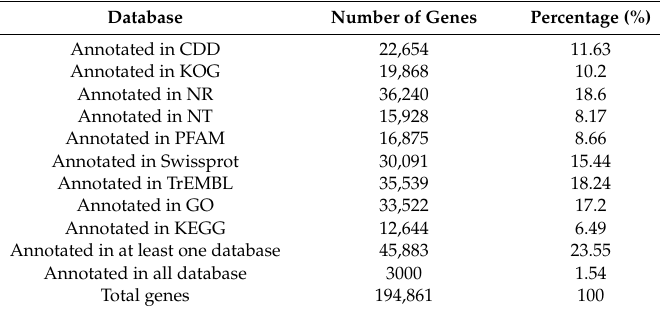
Table 3. Statistics of functional annotation.